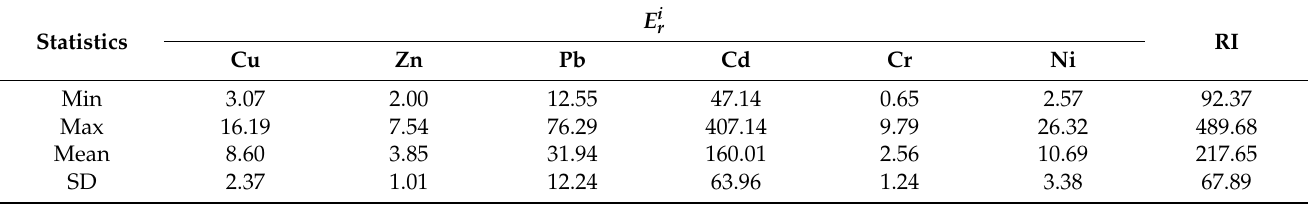
Table 5. Potential ecological risk index of heavy metals in